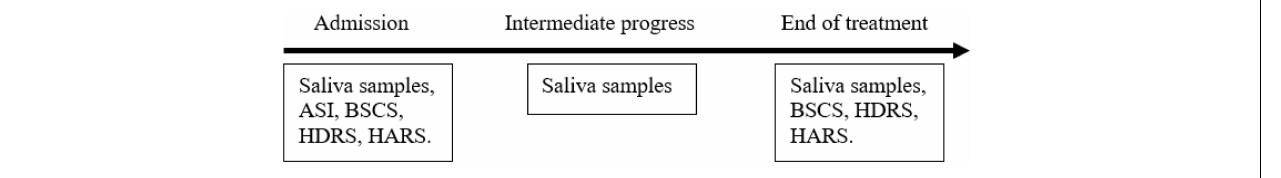
FIGURE 6 | Study timeline. The clinical scales and saliva samples were collected on days 2 and 7 of the trial and 1 day before the release from the detox center. ASI, Addiction Severity Index; BSCS, Brief Substance Craving Scale; HDRS, Hamilton Depression Rating Scale; HARS, Hamilton Anxiety Rating Scale.